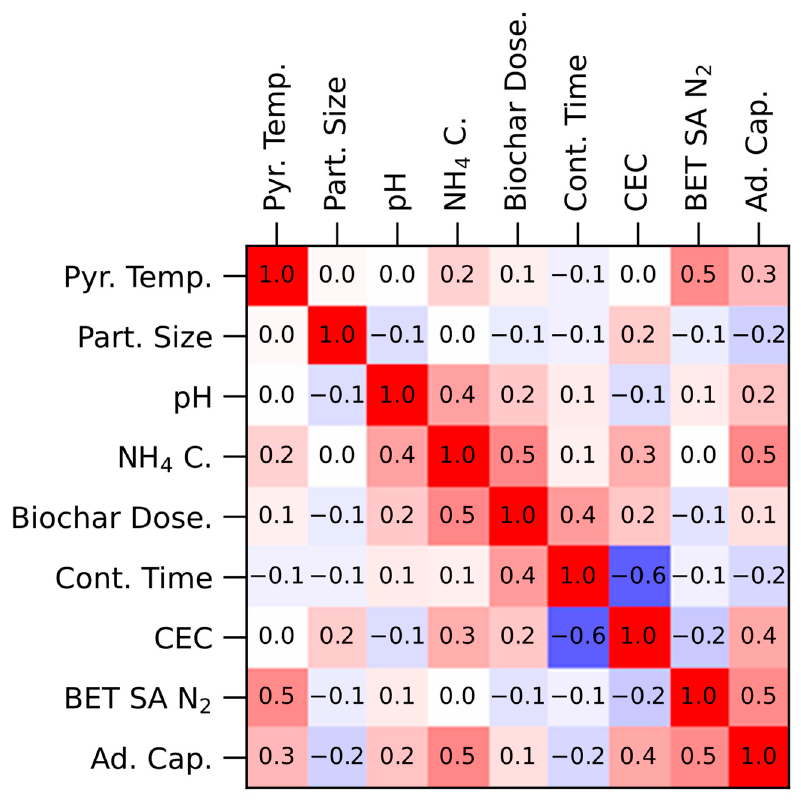
Figure 3. Correlation matrix for key influencing parameters; red indicates positive correlation and blue indicates negative correlation.